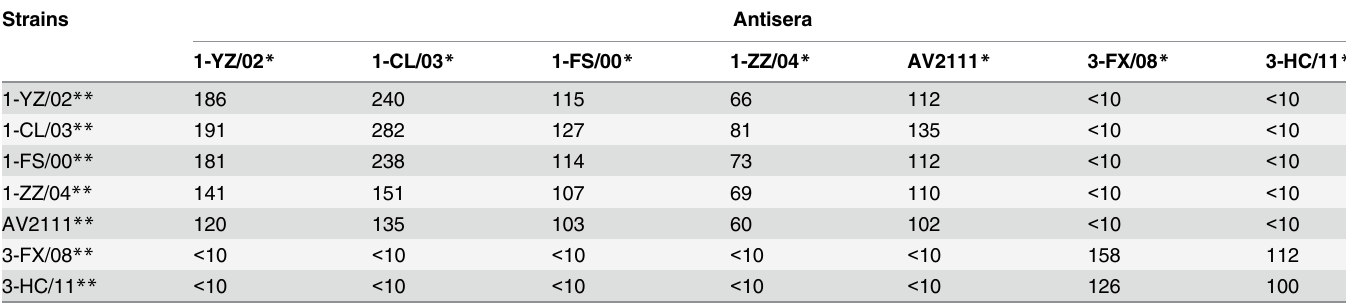
Table 3. Neutralization index among Different DHAV Strains.